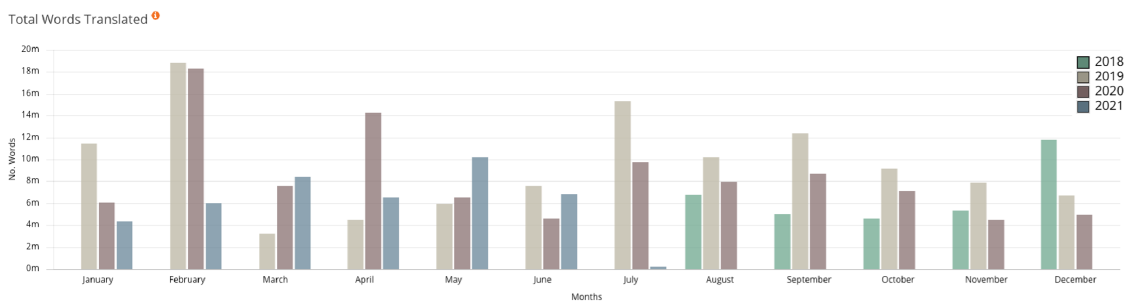
Figure 6. Total number of words translated per month on the KantanMT Platform. The statistics provided are from 1 August 2018 and are updated every 2